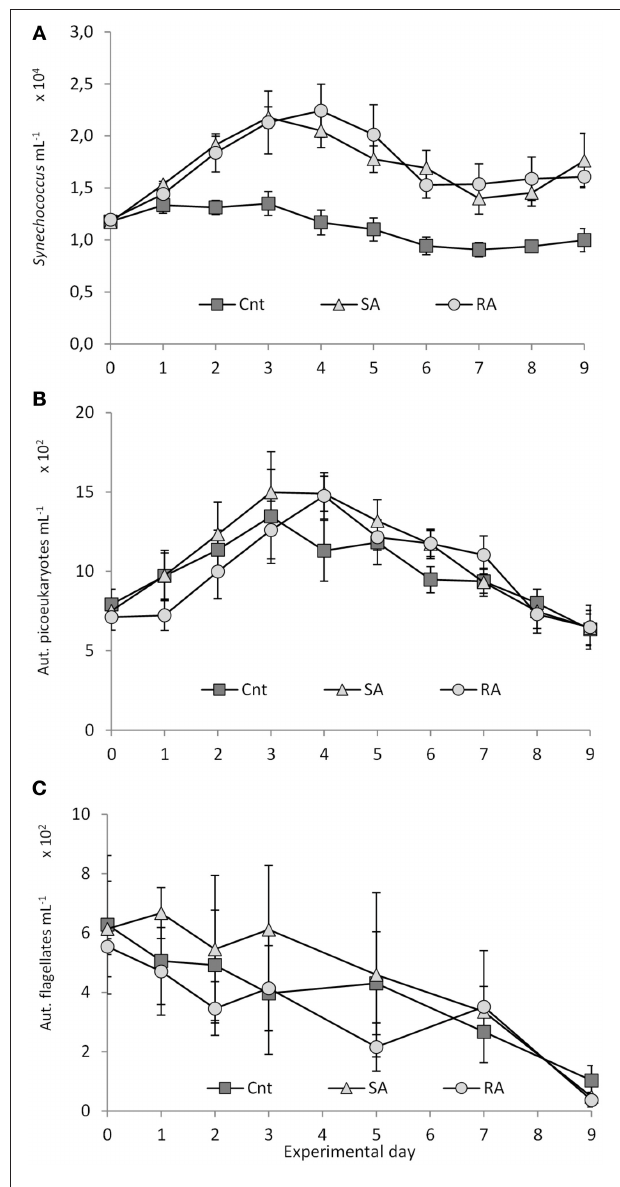
FIGURE 6 | (A) Synechococcus , (B) pico-eukaryote, and (C) autotrophic flagellate abundances during the mesocosm experiment. Cnt = Control mesocosms (no addition), SA = single addition, mesocosms where dust was added once, on the first day of the experiment, RA = repetitive